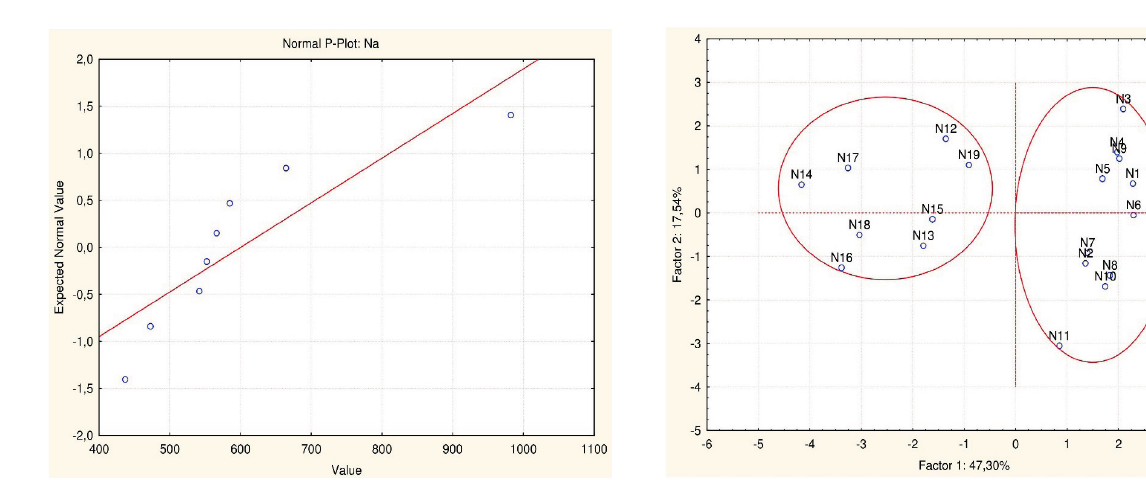
Figure 3: Normality data test for sodium in green tea samples.